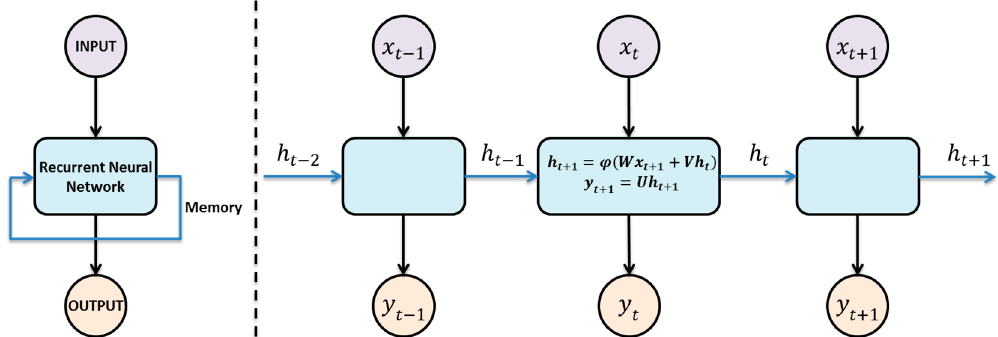
Figure 3. The structure of recurrent neural network (RNN) model.